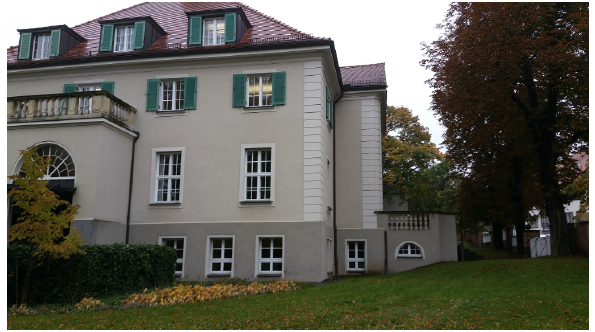
Figure 8: Photo of the principalship